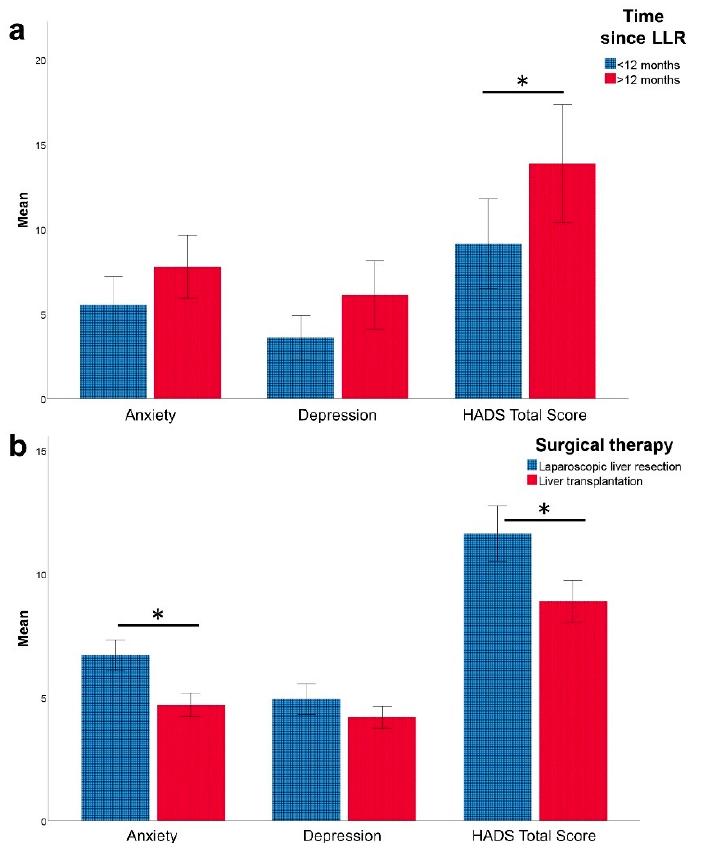
Figure 1. Mental health measured with Hospital Anxiety and Depression Scale (HADS) in patients with hepatocellular carcinoma (HCC) after undergoing laparoscopic liver resection (LLR). Error bars = standard error of the mean. * p < 0.05. ( a ) Mental health (HADS) in patients after LLR according to the time between LLR and completion of the questionnaire. ( b ) Comparison of mental health (HADS) of HCC patients after LLR and after orthotopic liver transplantation (OLT).